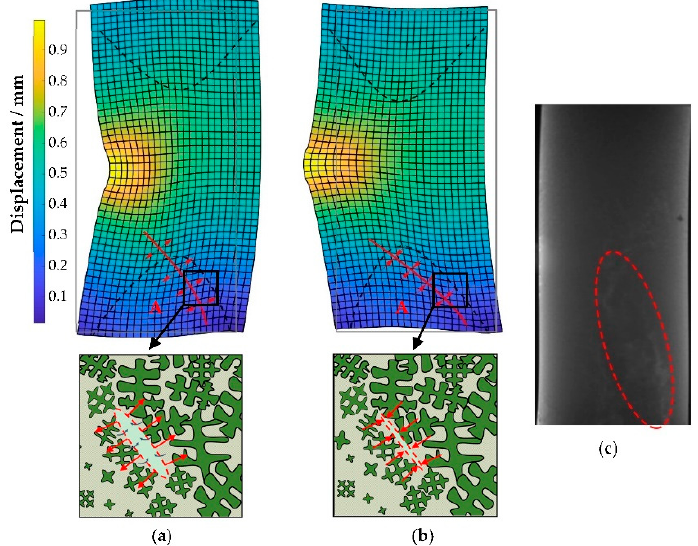
Figure 9. The deformation of the feeding channel magnified 100-fold at ( a ) 220 ms and ( b ) 240 ms, compared to ( c ) the morphology of the shrinkage defects of the casting with 24 Hz vibration. Note: Red arrows indicate the force directions, and the red dashed ellipses denote the position and direction of shrinkage